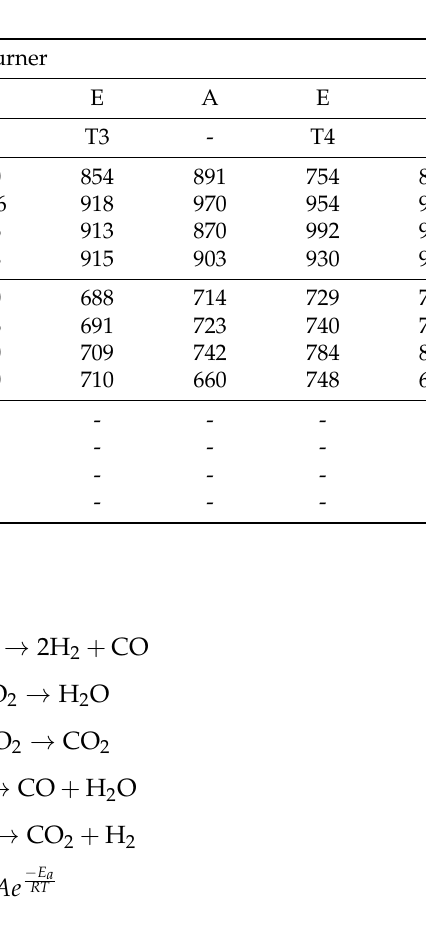
Table A2. Comparison of results from CFD modeling with experimental results using OEC technology + Modification of